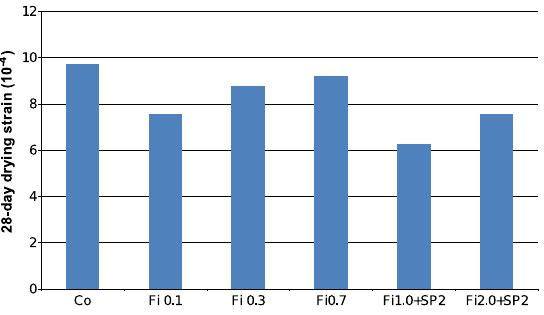
Figure 2. Drying shrinkage of mortar mixes.